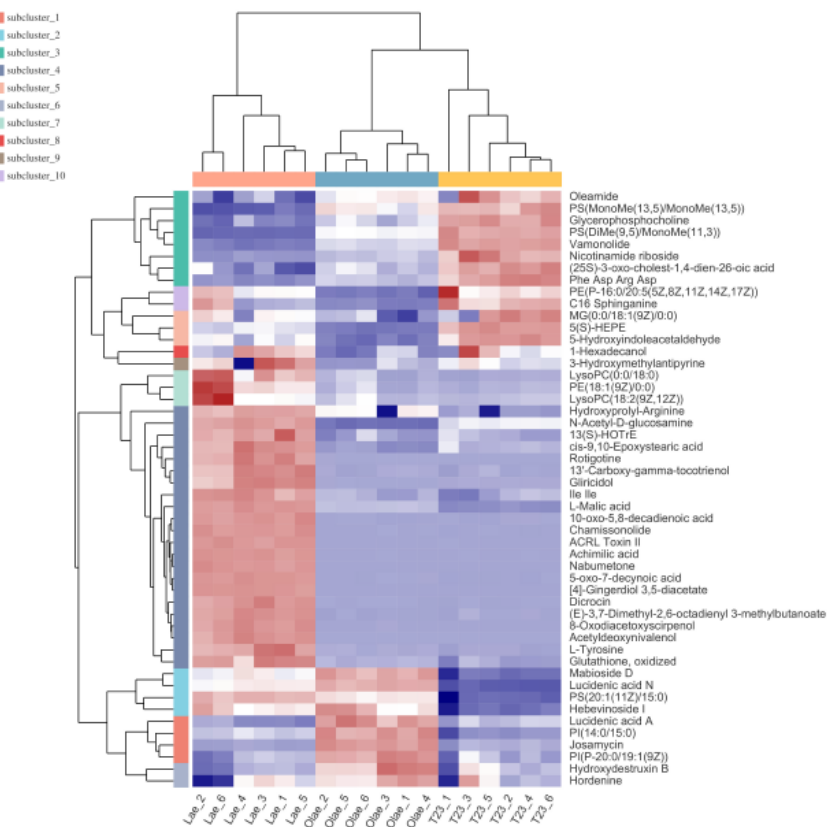
Figure 5. Hierarchical clustering analysis for identification of differently expressed metabolites. Each column in the figure represents a sample, each row represents a metabolite, and the color indicates relative amount of metabolites expressed in the group.